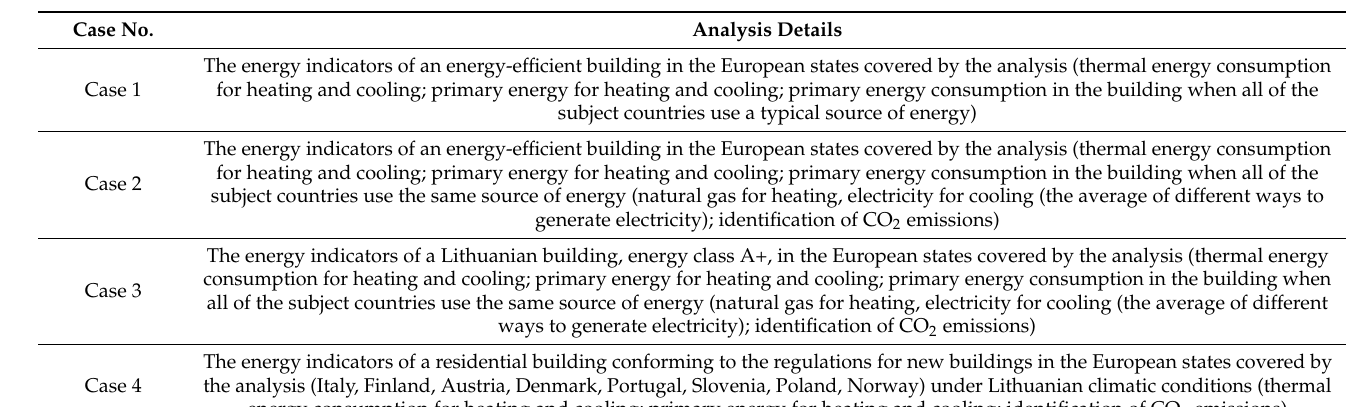
Table 10. Summary of phases of the analysis of the